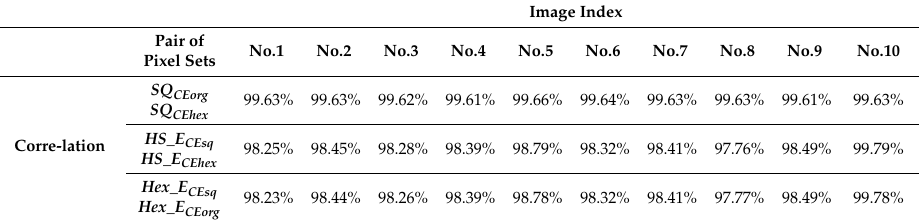
Table 3. Comparison of pixel sets on corresponding arrangements via two types of common spaces.